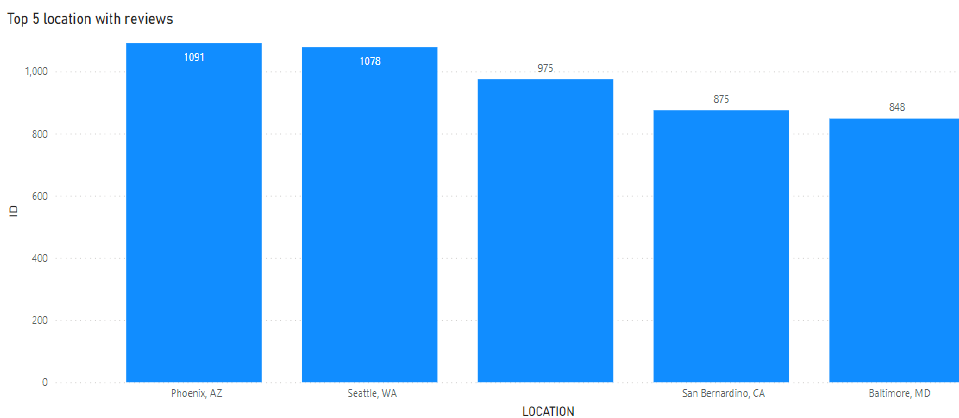
Figure 3. Top five locations chart for the provided reviews.